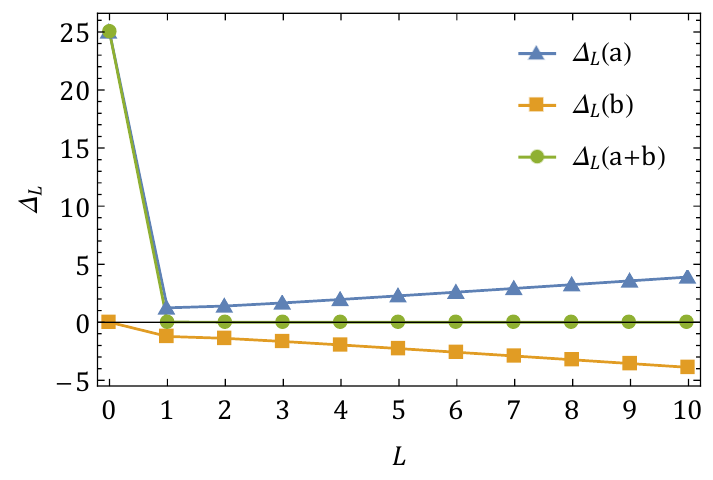
Figure 2 . The 1-loop correction to photon’s mass from a scalar with mass m = 1 of angular quantum number L of loop modes. The function (cid:1) L is de(cid:12)ned as in (2.35) and